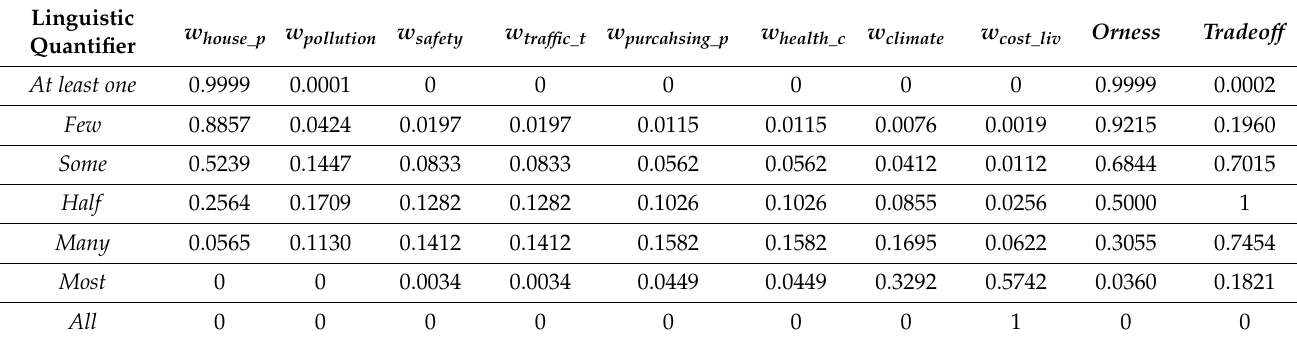
Table 4. Results of the recalculated weights for each